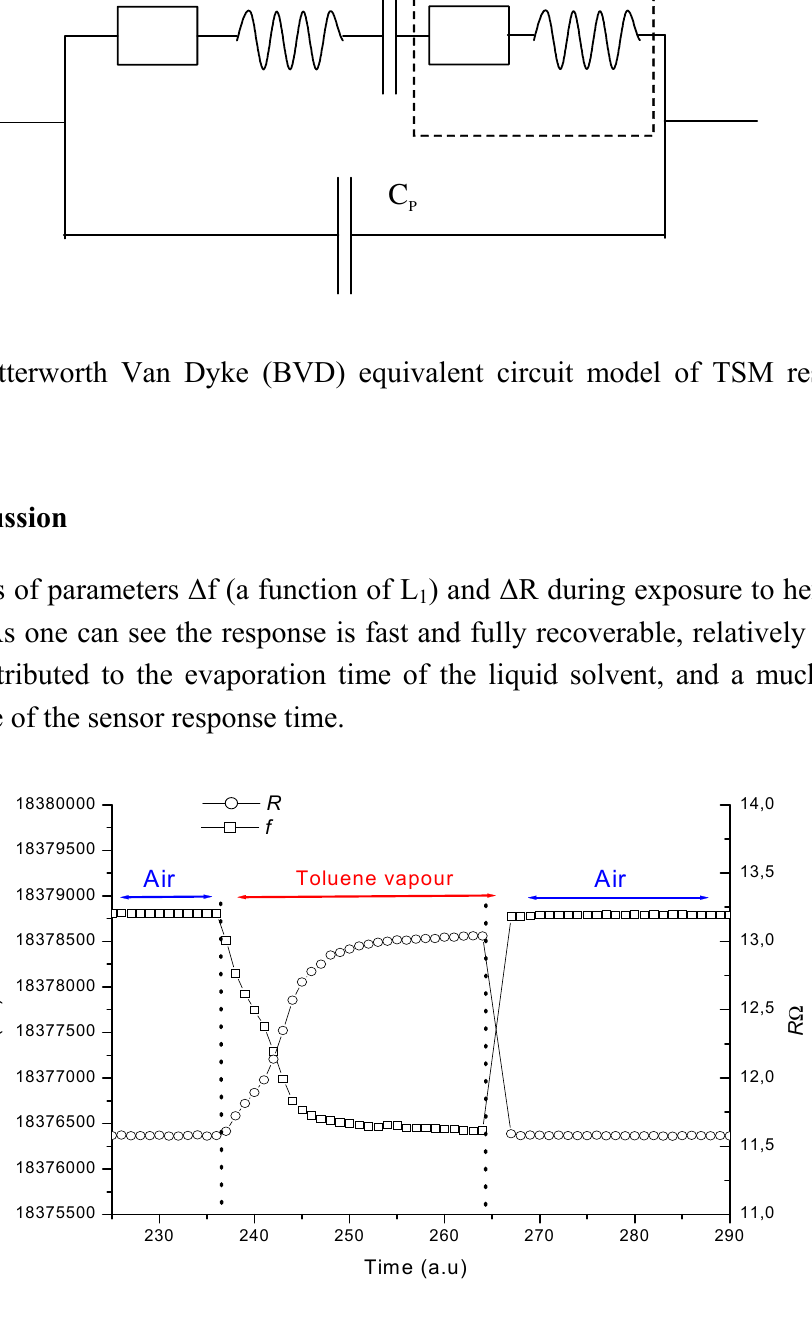
Figure 2. Pseudo real time plot of changes in frequency and resistance as a response on exposure to 25000 ppm of toluene